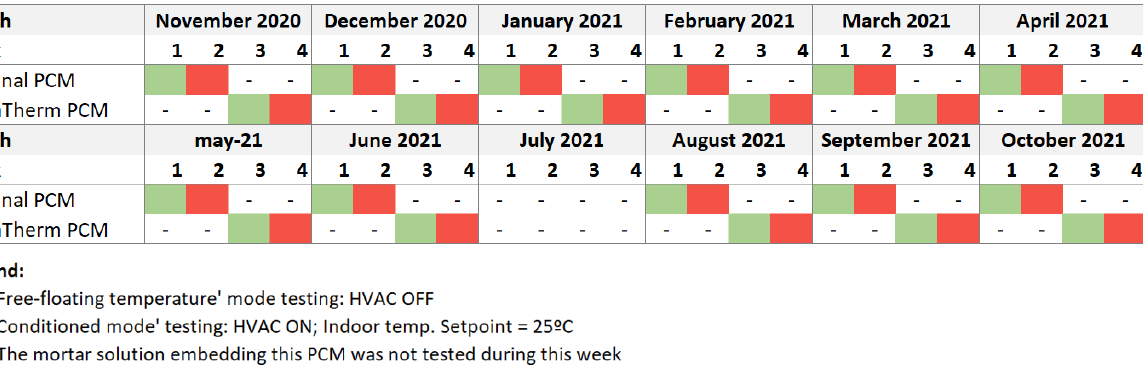
Figure 6. Annual calendar designed for the monitoring campaign alternatively testing both PCM- based mortars (with Micronal and CrodaTherm materials) under ‘Free-floating temperature mode’ and ‘Conditioned mode’.